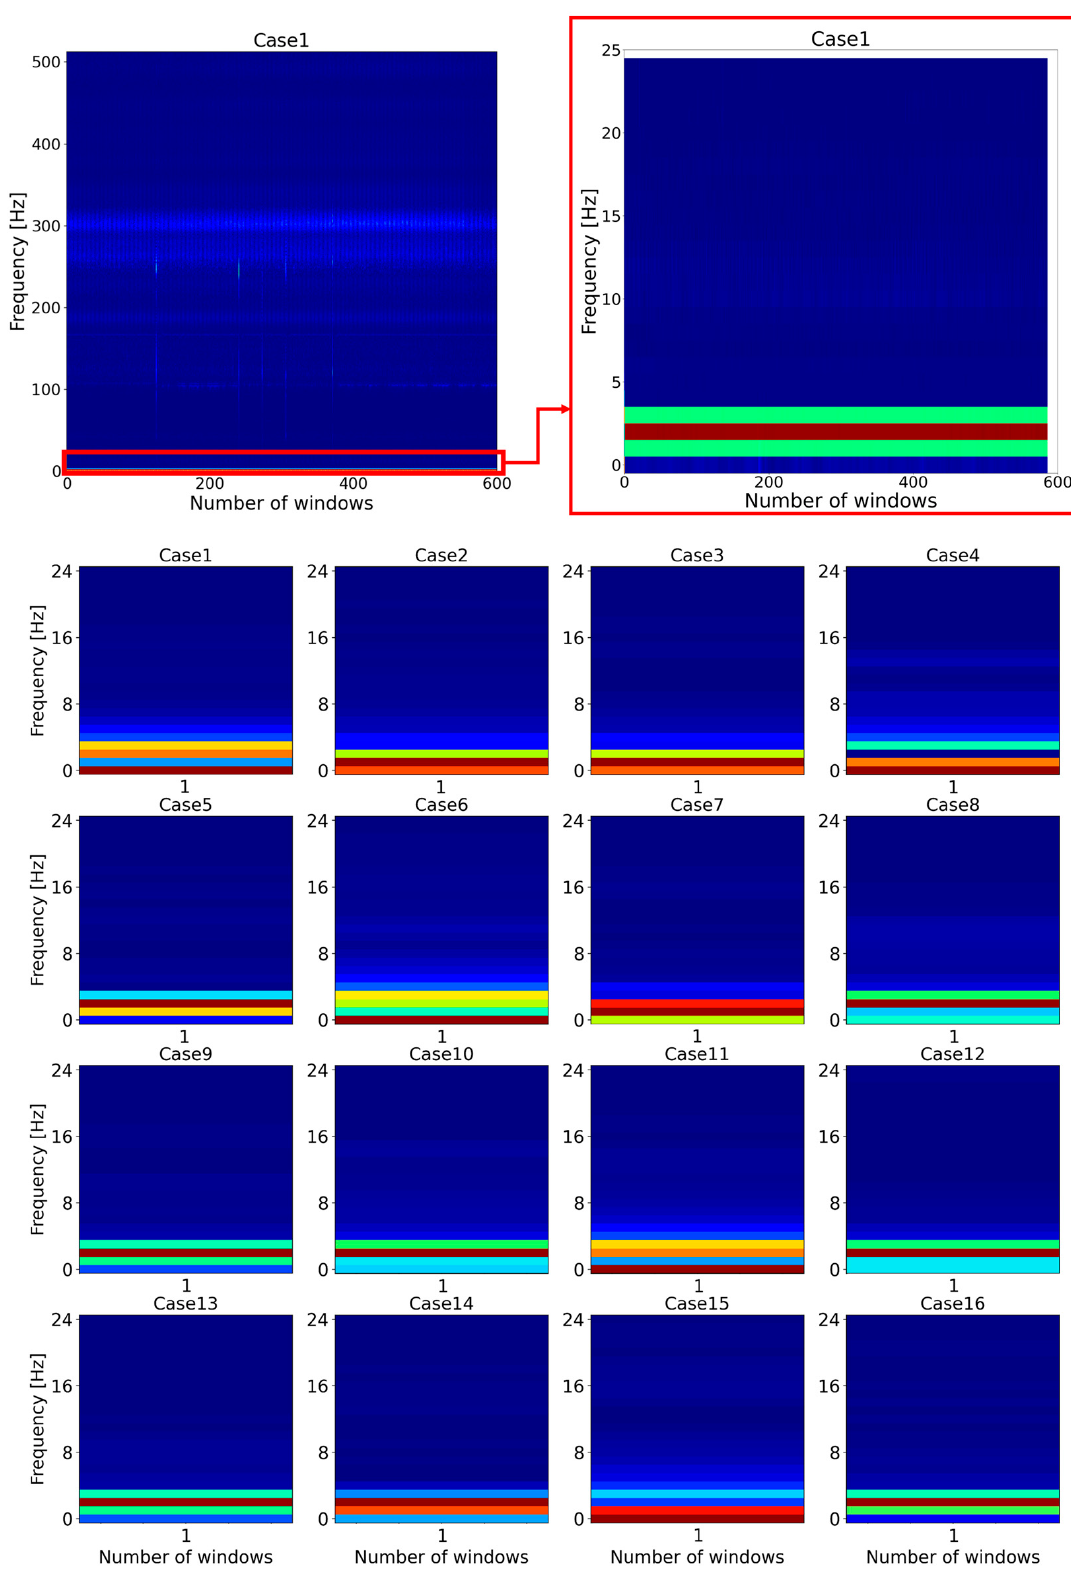
Figure 7. Representation of the feature reduction method for all cases.